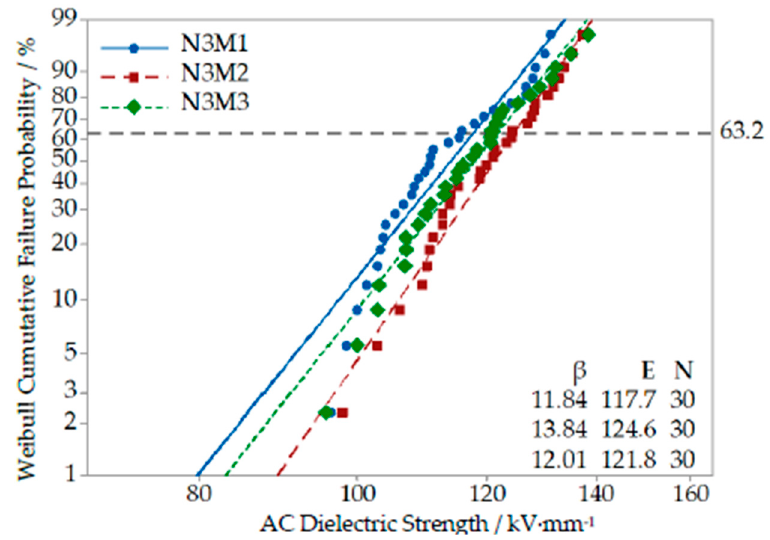
Figure 9. Weibull diagram of AC breakdown field strength of Micro-Nano-composites.